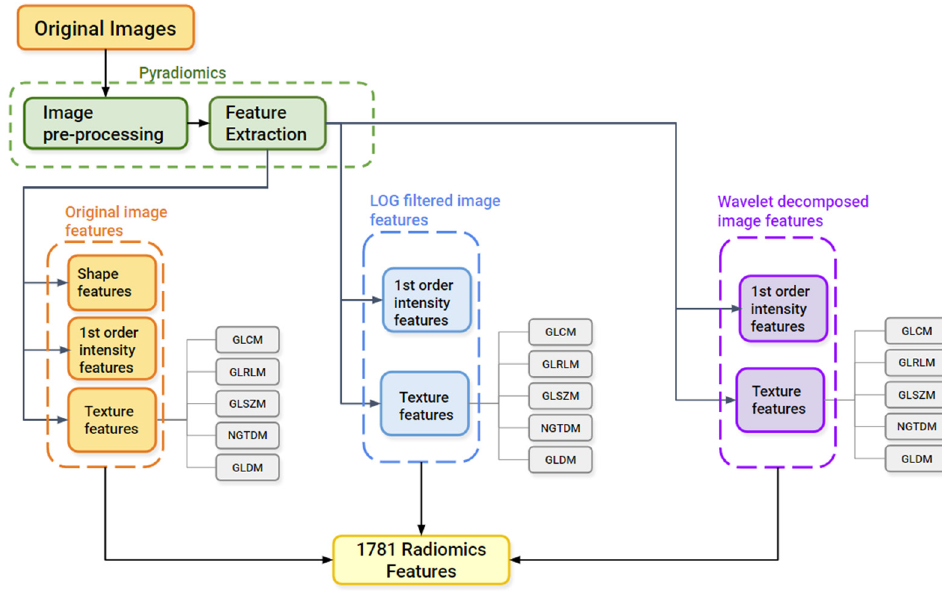
Figure 2. Feature extraction workflow.